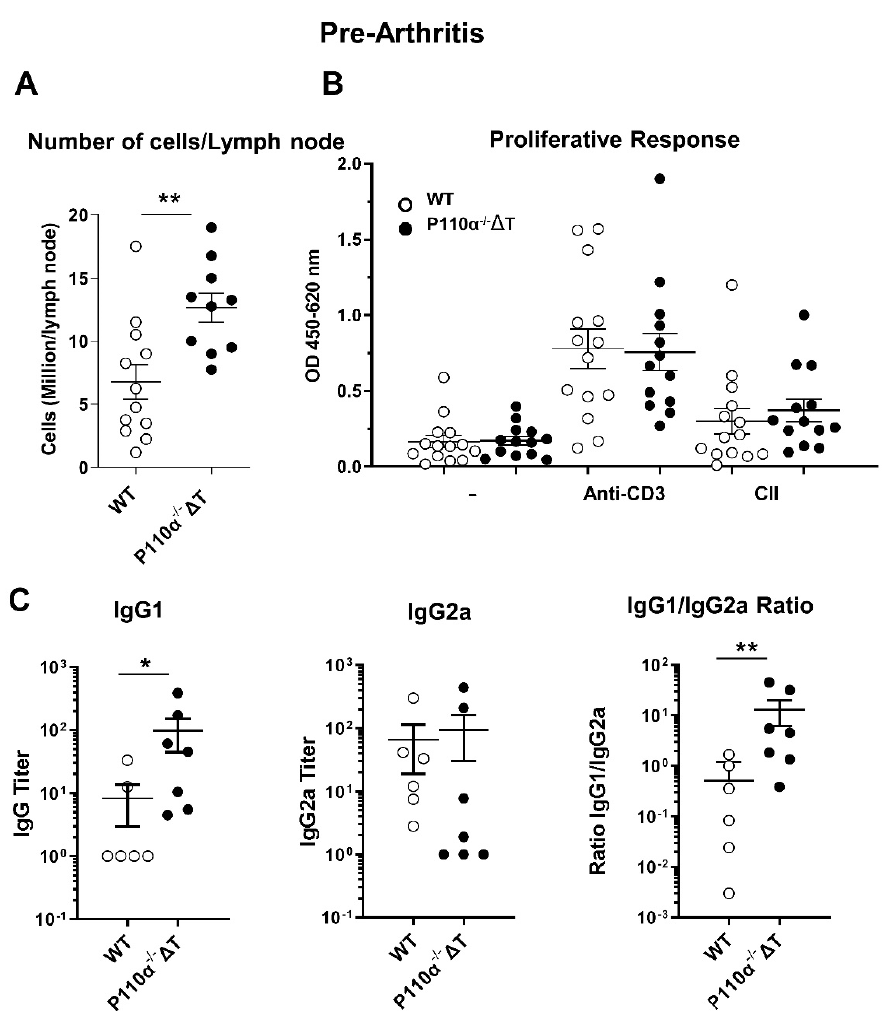
Figure 5. Immune response to Collagen II in p110 α − / − ∆ T mice before the onset of arthritis. Thirteen days after CII in CFA injection, WT and p110 α − / − ∆ T mice were analyzed. ( A ) Number of cells per draining lymph node. ( B ) The proliferative responses of lymph node cells from WT (white symbols) and p110 α − / − ∆ T (black symbols) mice were measured with WST-1 assay, after three days of in vitro stimulation with anti-CD3 Ab, Collagen II (CII) or vehicle (PBS, -) as indicated in the figure. Mice were individually analyzed ( n = 14 for WT and n = 13 for p110 α − / − Δ T) and cultures were set up in triplicates. ( C ) The level of IgG1 ( C , left) and IgG2a (( C ), center) anti-CII Abs in the sera was analyzed by ELISA in WT (white symbols) and p110 α − / − Δ T (black symbols) mice. The ratio of anti-CII IgG1/IgG2a antibody titer for each mouse in a representative experiment is shown in ( C ), (right panel). * p < 0.05; ** p < 0.01. Data show the mean ± SEM from individual mice analyzed. Although the mice did not show clinical symptoms of arthritis at this time, the sera collected at 13 days post-Ag were analyzed for collagen-specific Abs. At this stage we